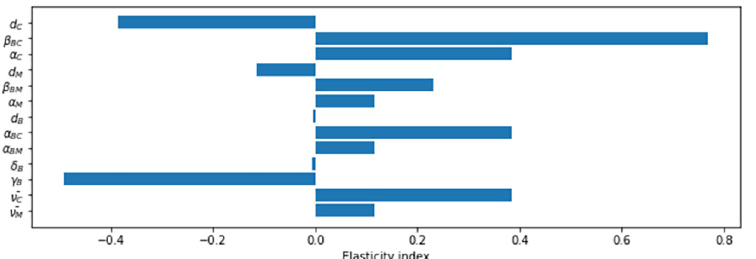
Fig 5. Sensitivity analysis results. X-axis corresponds to the elasticity index for the parameter. The magnitude of these values shows the strength of the relationship, while the sign tells whether the relative change in the parameter increases or decreases the magnitude of � R . For example, the elasticity index of β is a large positive value meaning that an BC 0 increase in the bird biting rate of the enzootic vector will result in a large increase in � R . On the other hand, γ has a B 0 large negative elasticity index meaning an increase in the bird recovery rate will decrease � R . Variables with elasticity 0 values that are close to zero have little to no impact on � R when they change. 0